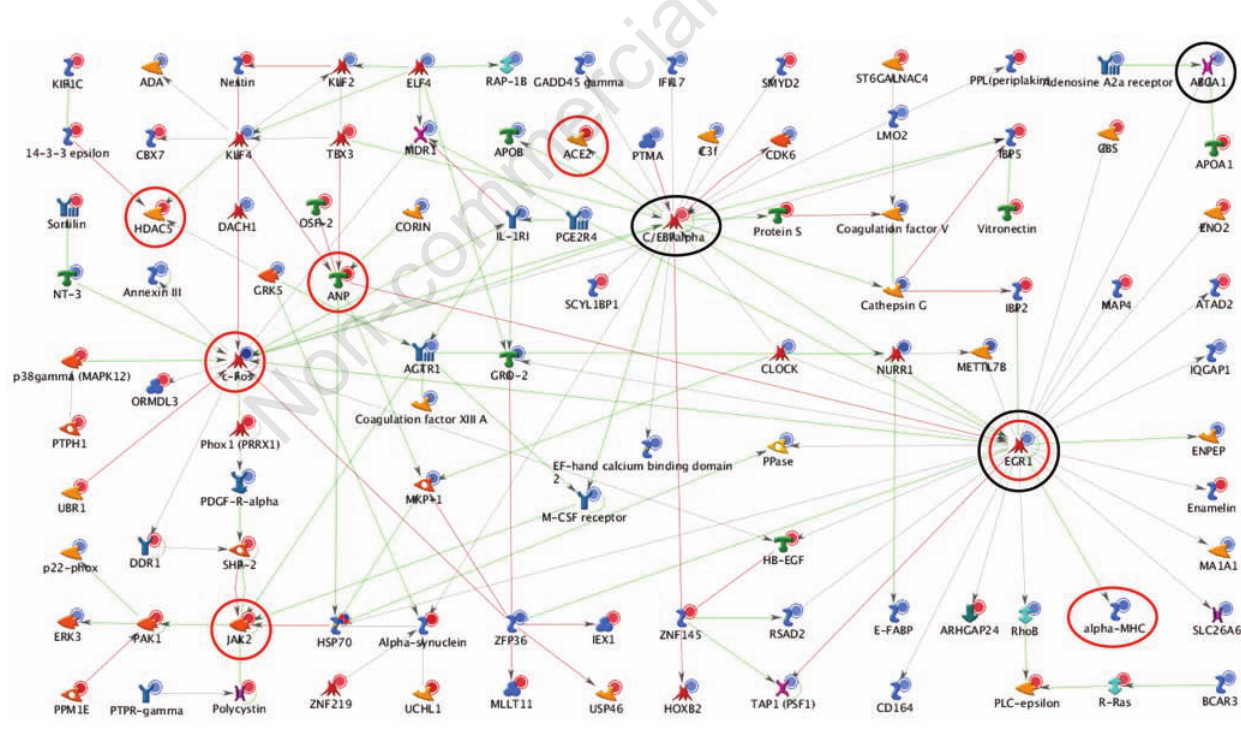
Figure 1. MetaCore™ direct interaction network analysis. 101 of the 493 (~20.5%) differentially expressed transcripts could be connect- ed by direct interaction in the network analysis. Encircled with red are important genes and transcription factors, further discussed in the discussion. Encircled with black is not present in the 493 transcripts. Green arrows indicate activation and red arrows inhibition. The symbols are as